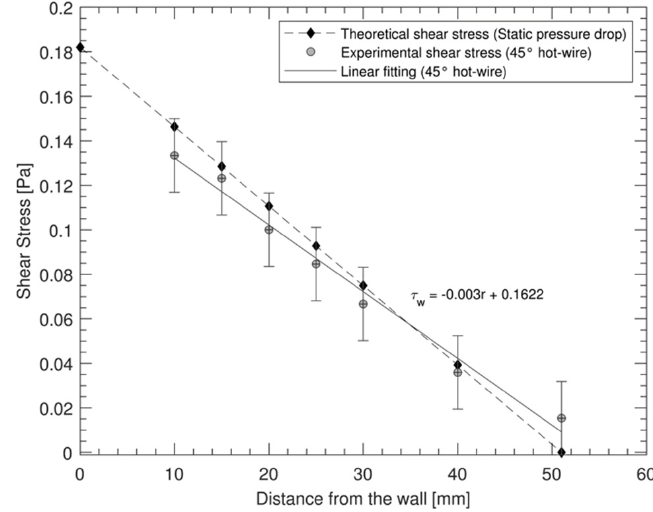
Figure 3. Theoretical and experimental shear stress across the pipe.